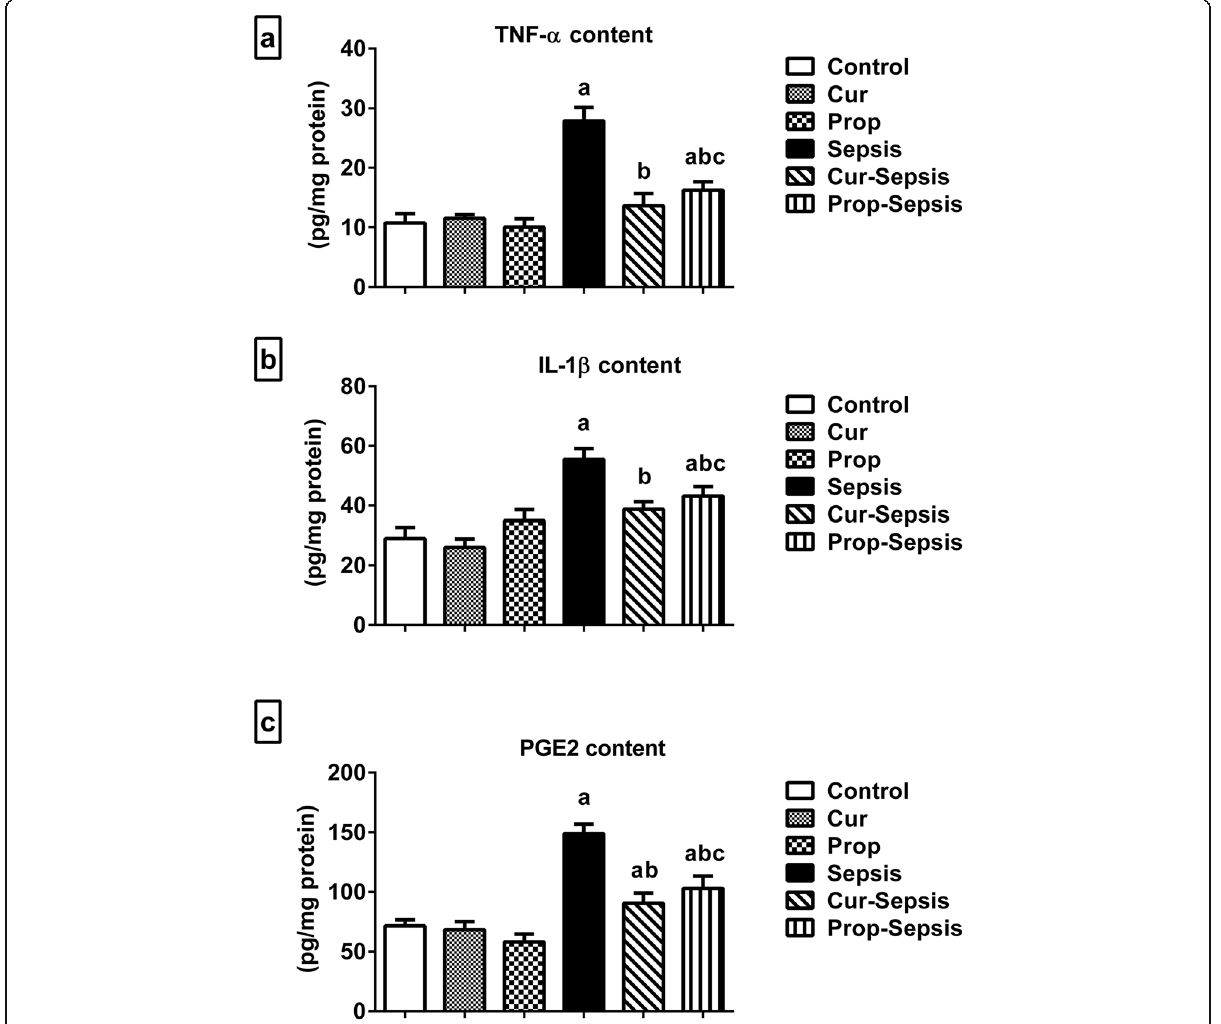
Fig. 3 The effect of either propolis (Prop) or curcumin (Cur) on a interleukin-1 β (lL-1 β ), b TNF- α , and c prostaglandin E2 (PGE2) in kidney tissue homogenate after sepsis-induction in adult male rats. Data are expressed as mean ± S.E.M for 6 rats/group. a, significant difference from control group by one-way ANOVA at P < 0.05; b significant difference from SEP group a by one-way ANOVA at P < 0.05; c, significant difference between cur and prop-sepsis and cur-sepsis groups by one-way ANOVA at P <